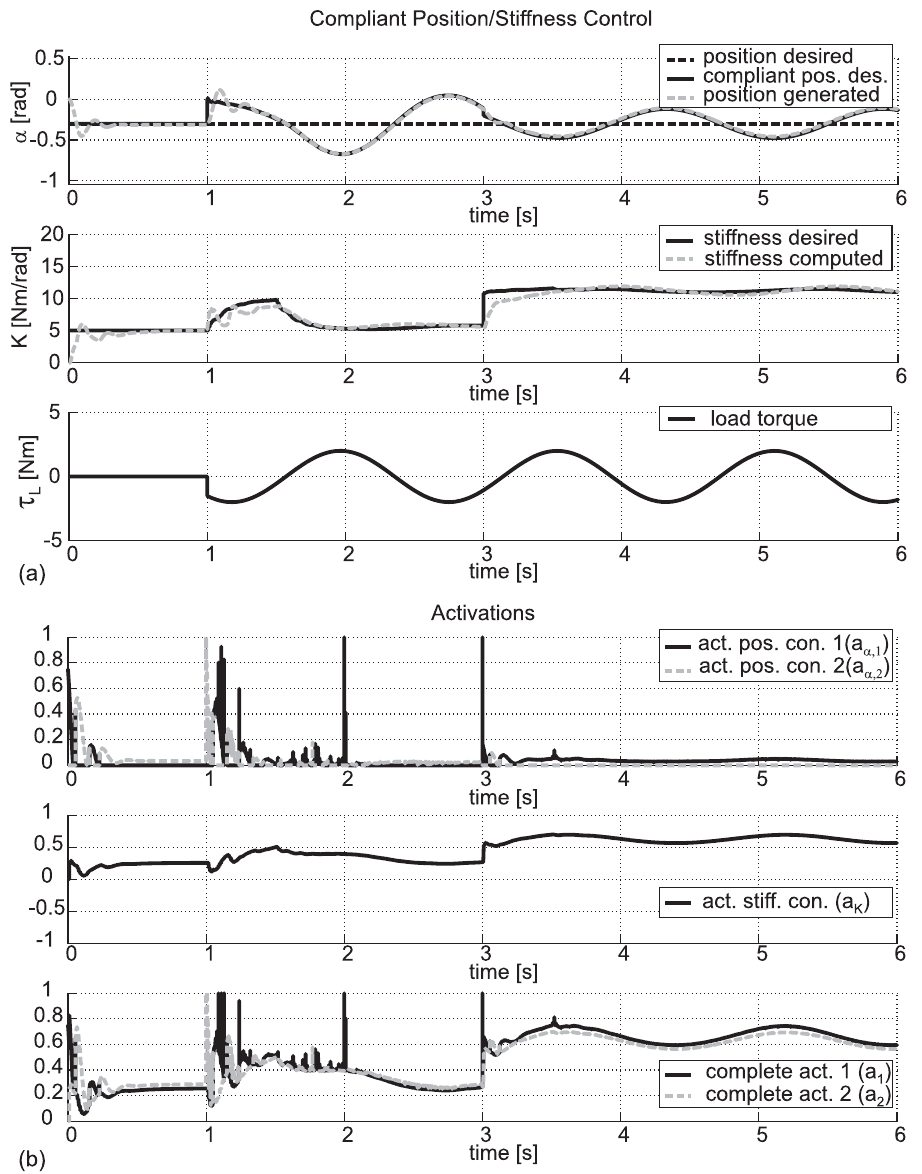
Fig. 7. Simulation results of the concurrent Position/Stiffness Controller with a compliant behavior for an antagonistic muscle pair in a hinge joint setup. (a) A sinusoidal torque is applied to the extremity of the lever at t =1s. The desired compliant position is modified based on the actual stiffness. At t =3 the desired stiffness doubles its value and the desired compliant position is modified accordingly. (b) Activations for the results in (a) are depicted. The position controller activates only one muscle at a time (either a α, 1 or a α, 2 is different than zero). The stiffness controller acts on both muscles with the same activation value a K . Muscles receive the complete activation as the sum of the two ( a 1 = a α, 1 + a K and a 2 = a α, 2 + a K